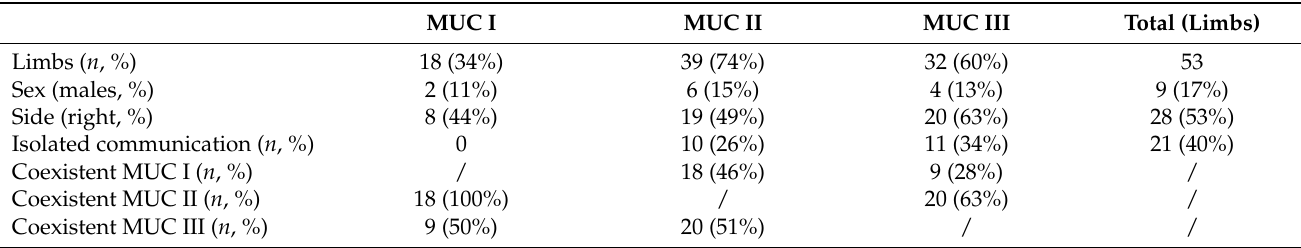
Table 3. Features of median-to-ulnar communicating branch in 36 patients with carpal tunnel syndrome and MUC. MUC—median-to-ulnar communicating branch.